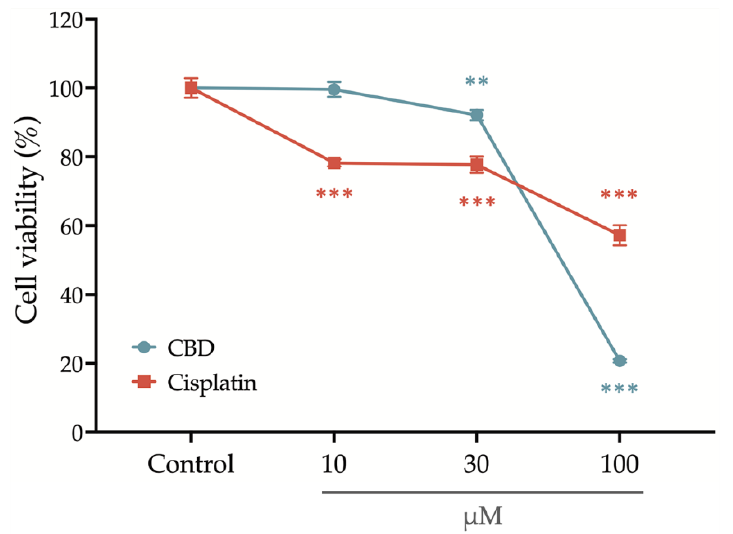
Figure 1. Cytotoxic effect of CBD and cisplatin on the viability of OEC-M1 cells. After the treatment with 10, 30, and 100 μM CBD (blue line) and cisplatin (red line) for 24 h, the viability of OEC-M1 cells was determined using an alamarBlue assay. Untreated cells with an equivalent percentage of DMSO were used as the control group. All data are represented as mean ± standard error mean (SEM) for at least three independent experiments. ** p < 0.01; *** p < 0.001 compared with the control group.